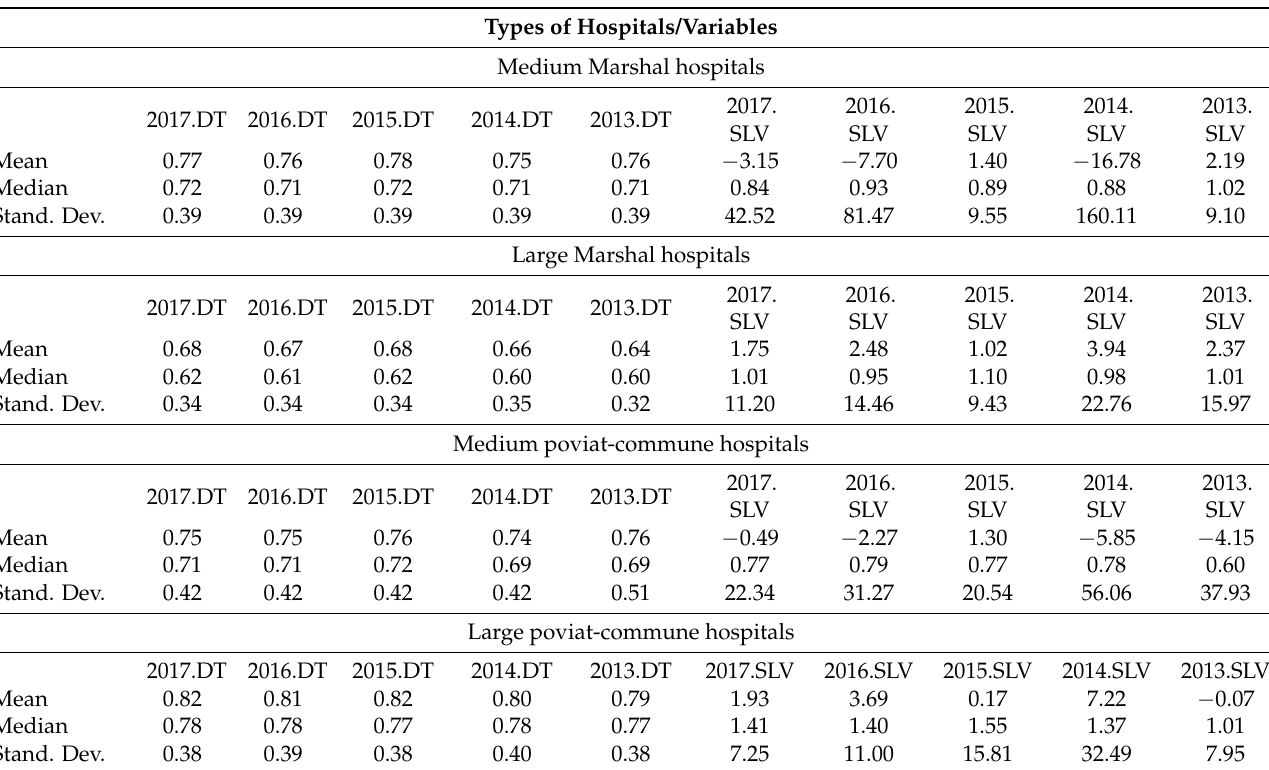
Table 4. Descriptive statistics of analyzed groups of hospitals. Types of Hospitals/Variables